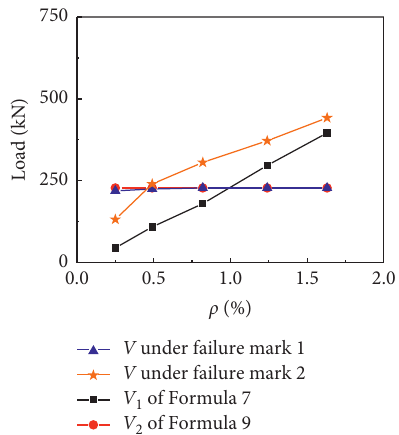
Figure 32: The shear bearing capacity of FEA and